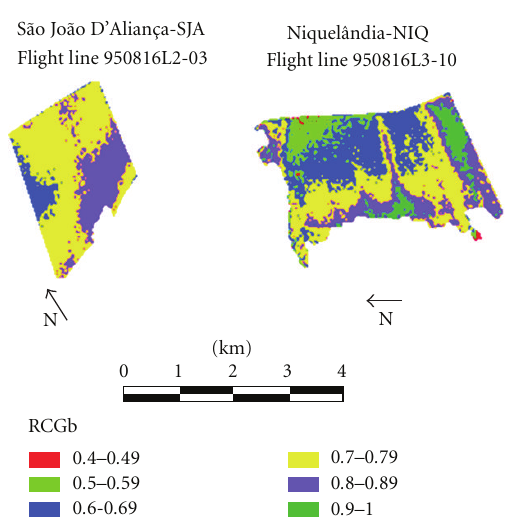
Figure 5: Quantitative mapping of the ratio kaolinite/(kaolinite +